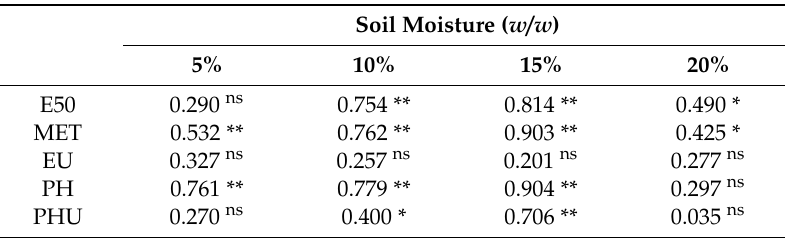
Table 5. Correlation coe ffi cients (r) of control and priming of the time to achieve 50% plant emergence (E50), mean plant emergence time (MET), plant emergence uniformity (EU), plant height (PH), and plant height uniformity (PHU) under four soil moisture conditions.